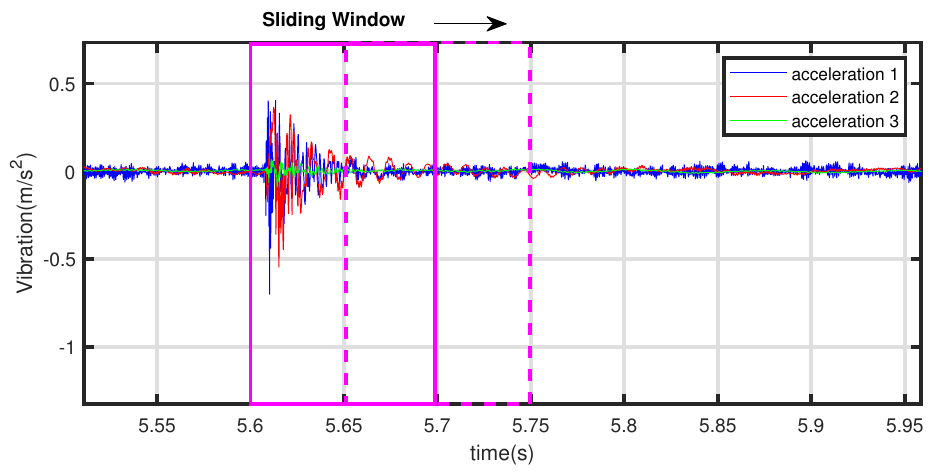
Figure 11. Sliding window for online vibration detection